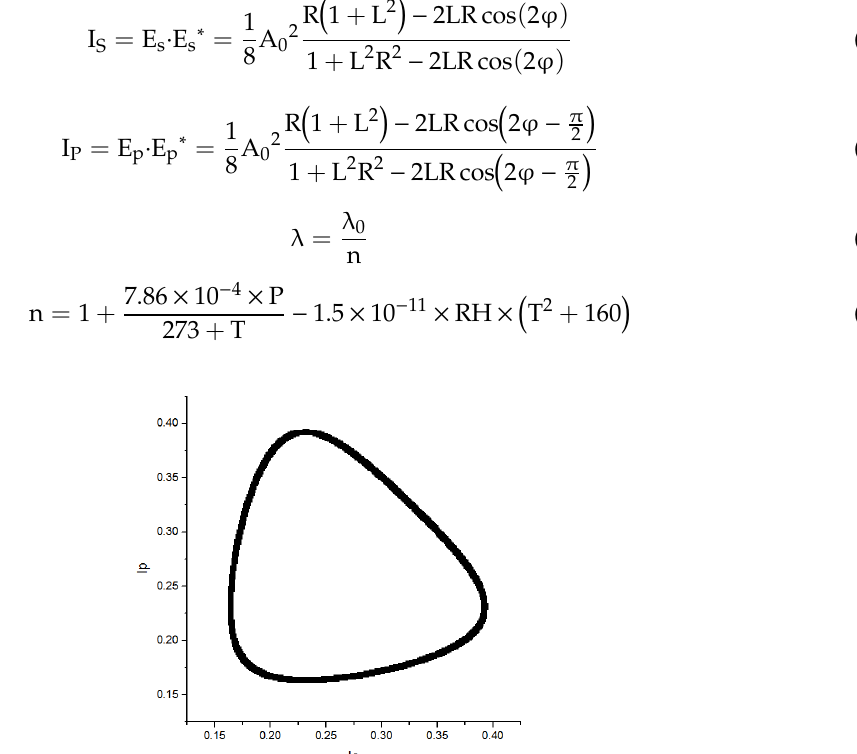
Figure 3. Orthogonal signal of the folded Fabry–Pérot interference.